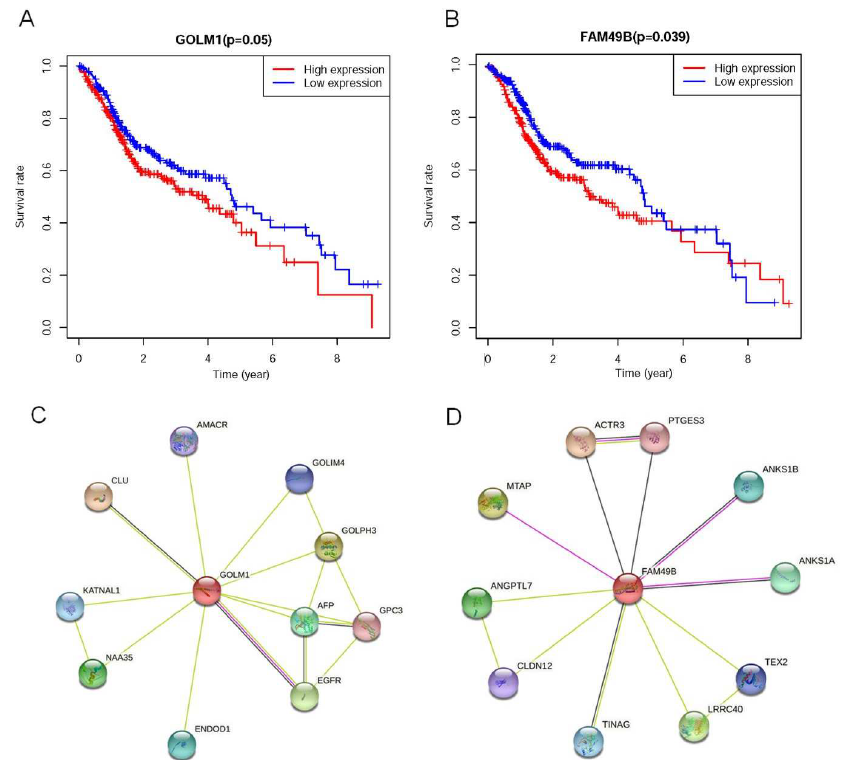
Figure 3. The effect of different gene expressions on OS in HNSCC and PPI network of GOLM1 and FAM49B. ( A ) K–M analysis of OS between the high FAM49B expression group and low FAM49B expression group in HNSCC. ( B ) K–M analysis of OS between the high GOLM1 expression group and low GOLM1 expression group in HNSCC. ( C ) Genes correlated with GOLM1 were shown. ( D ) Genes correlated with FAM40B are shown.